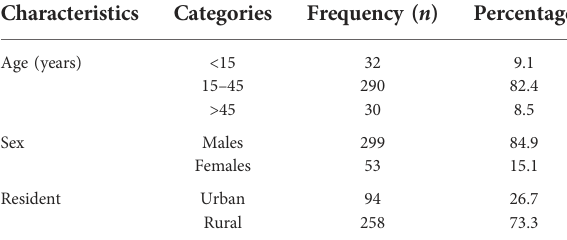
TABLE 1 Socio-demographic characteristics of study subjects with penetrating abdominal trauma who underwent surgical exploratory laparotomy during 2015 – 2019 at Hiwot Fana Specialized University Hospital, eastern